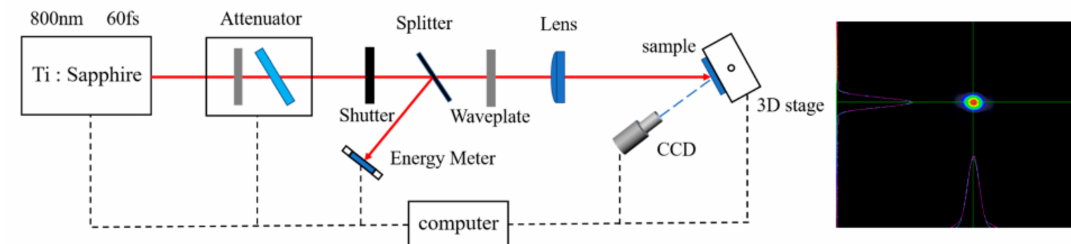
Figure 2. ( Left ) Experimental setup for laser damage tests at 60 fs and 800 nm. ( Right ) Image of the laser beam intensity distribution at the sample